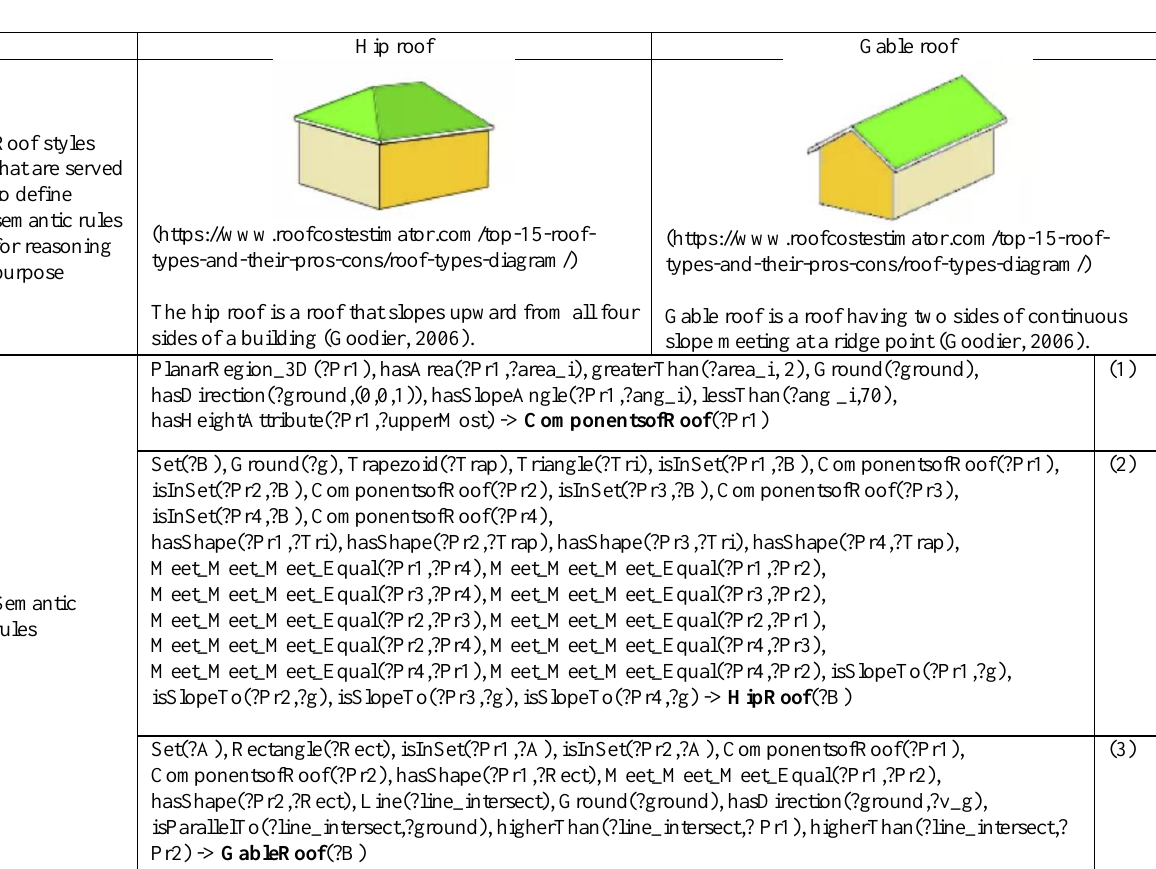
For example, in the hip roof example, the intersection line between Pr2 and Pr4 detected from point clouds is presented in Figure 2. The intersection parts between the intersection line and planar segments are shown in Figure 3. The endpoints representing the line segments are detected from points as shown